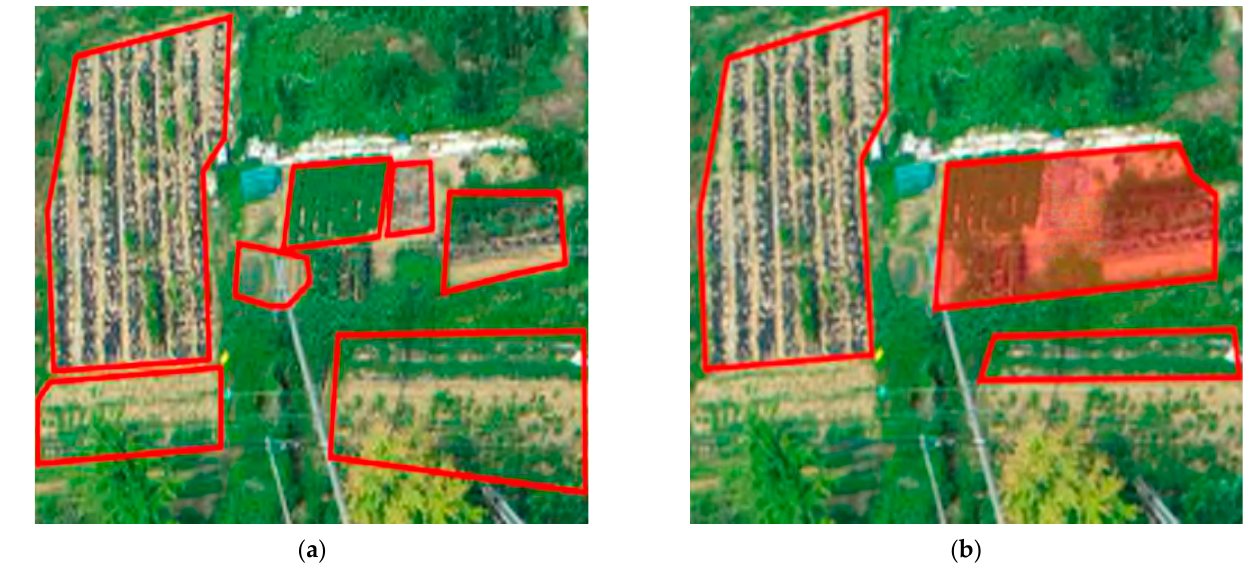
Figure 9. Annotation of cultivated land. ( a ) annotation normal appearance; ( b ) annotation error (red polygon). Table 2. Cumulative number of training data collected per block.